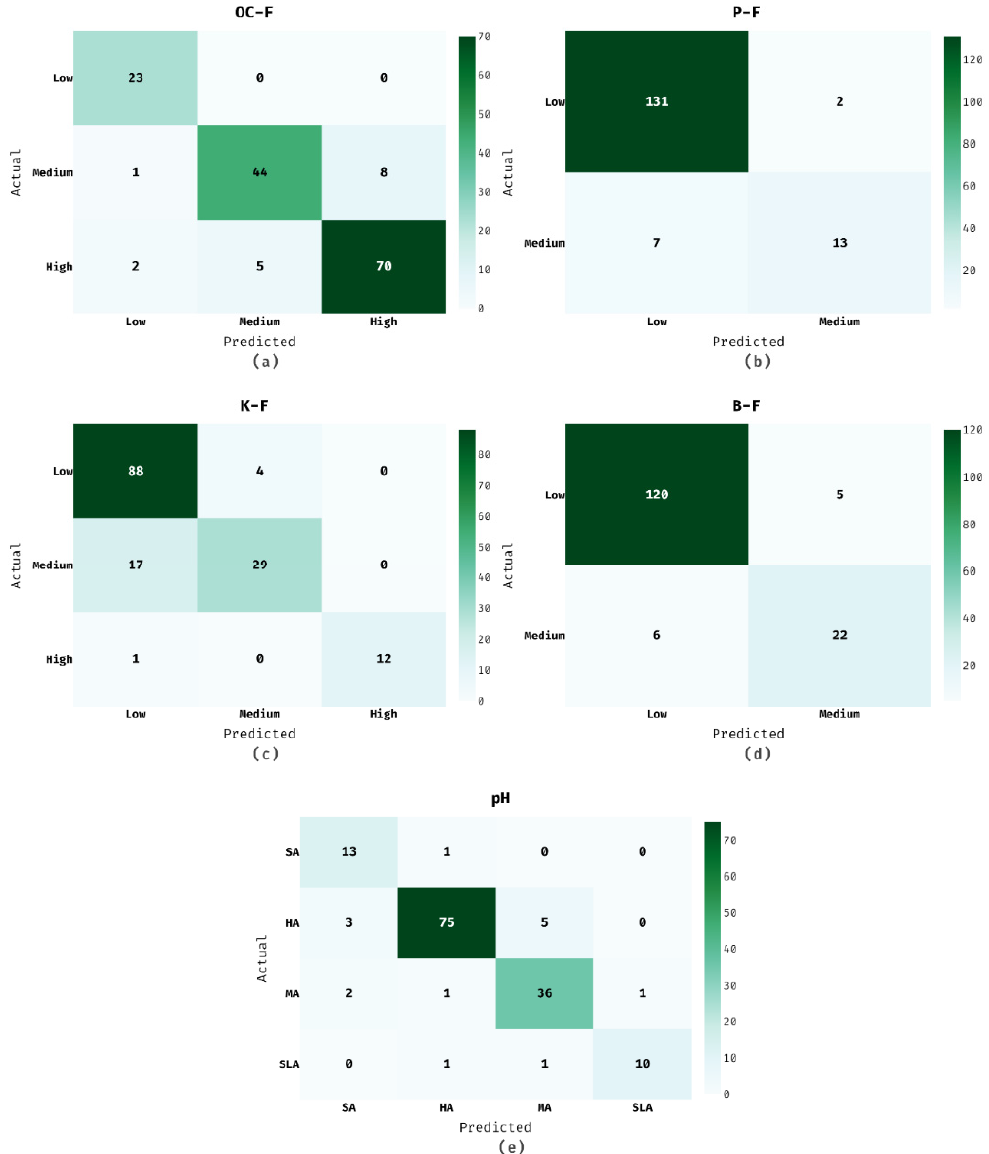
Figure 4. Confusion matrix of ISNpHC-WVE model.